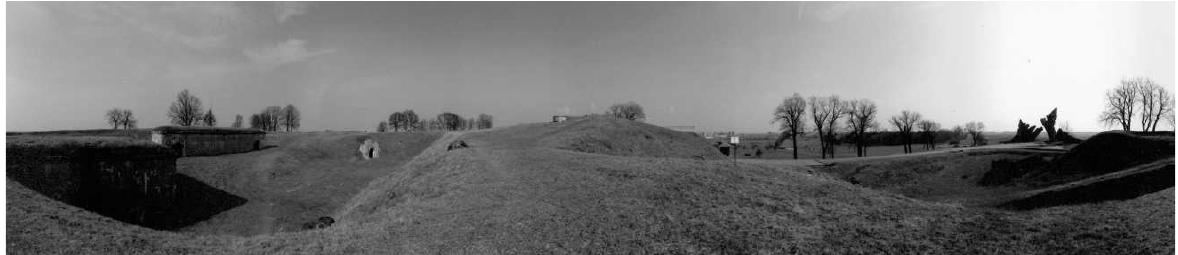
Fig 8. Fort IX in 2006 (Photo by V.